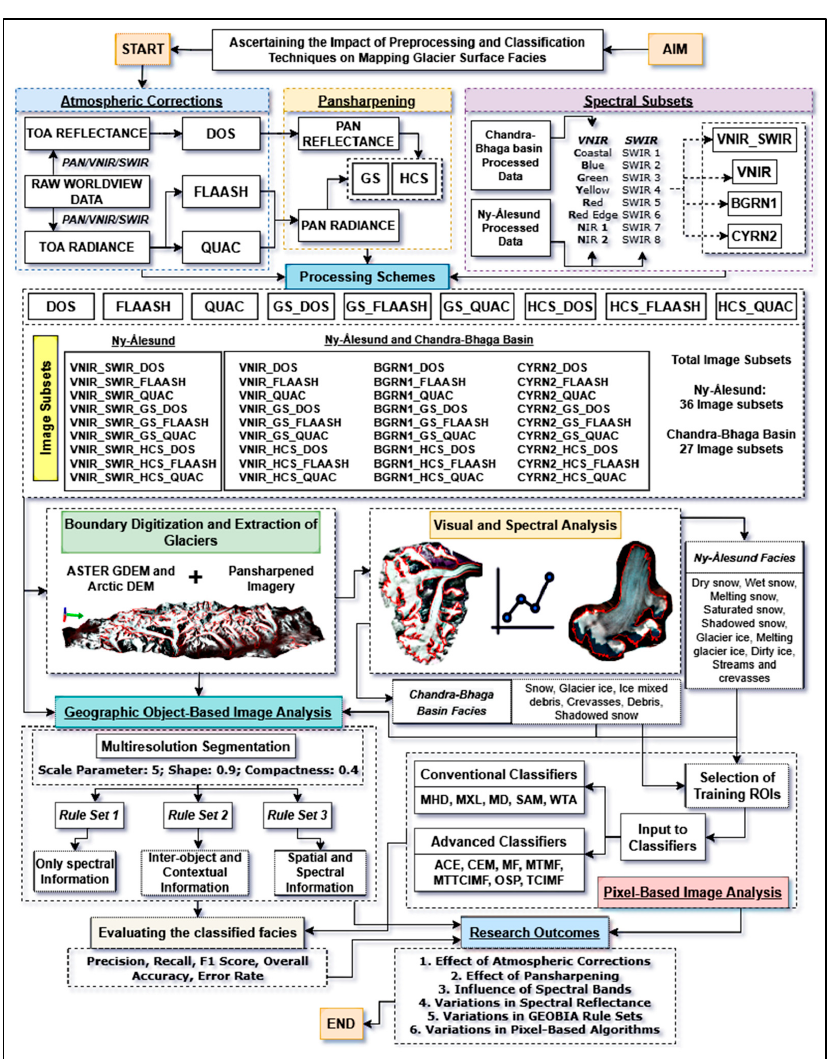
Figure 2. Highlights the broad design of the experiment. TOA: Top of Atmosphere; MSS: Multispectral; PAN: Panchromatic; DOS: Dark Object Subtraction; QUAC: Quick Atmospheric Correction; FLAASH: Fast-Line-of-Sight Atmospheric Analysis of Spectral Hypercubes; HCS: Hyperspherical Color Space; GS: Gram–Schmidt; SAM: Spectral Angle Mapper; MD: Minimum Distance; MXL: Maximum Likelihood; MHD: Mahalanobis Distance; WTA: Winner Takes All; MF: Matched Filtering; MTTCIMF: Mixture-Tuned Target-Constrained Interference-Minimized Filter; TCIMF: Target-Constrained Interference-Minimized Filter; ACE: Adaptive Coherence Estimator; CEM: Constrained Energy Minimization; OSP: Orthogonal Space Projection; MTMF: Mixture-Tuned Matched